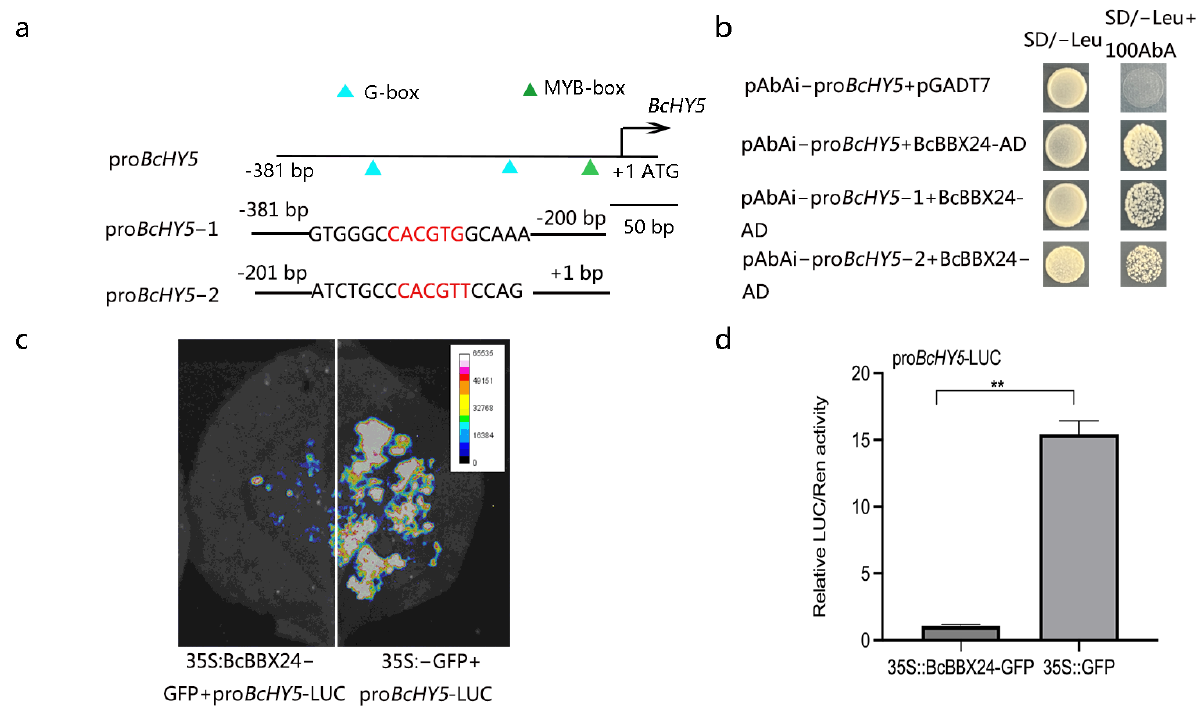
Figure 6. BcBBX24 binds to the BcHY5 promoter and represses its expression. ( a ) Distribution of light-responsive cis-elements in the BcHY5 promoter region. Blue triangles indicate G-boxes (G1-box: − 220 bp to − 226 bp; G2-box: − 92 bp to − 98 bp), and green triangles indicate the MYB motif. ( b ) Yeast one-hybrid assays of BcBBX24 and the promoter of BcHY5 . ( c ) Representative images of transient expression in Nicotiana benthamiana . ( d ) Activation effects of the BcBBX24 on the BcHY5 promoter. LUC/Ren, ratio to firefly to Renilla luciferase activity. Asterisks (** p < 0.01, Student’s t -test) indicate the statistical significance of the difference between the two groups.